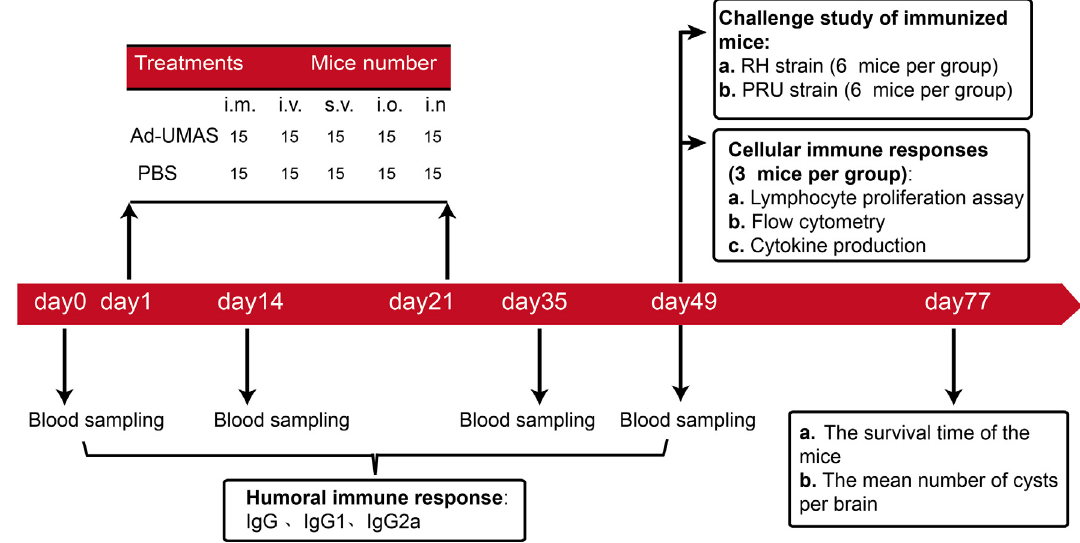
Figure 1. Study flowchart presenting groups of mice vaccinated with Ad-UMAS via different immunization